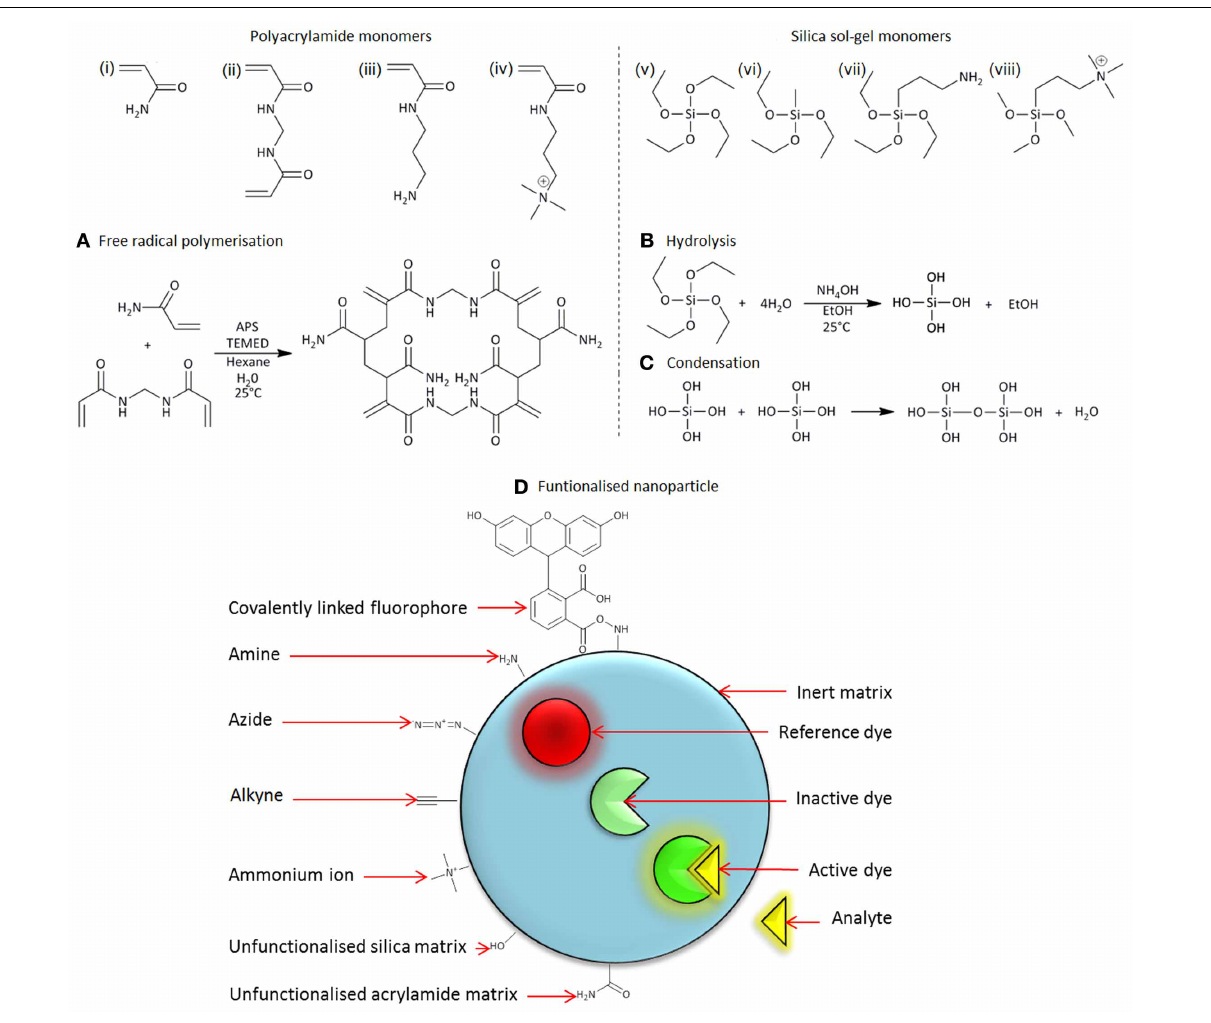
(MTEOS), (vii) (3-aminopropyl) triethoxysilane, and (viii)-trimethoxy silylpropyl-N,N,N- trimethyl-aminium (TMAC). (A) Free radical polymerization of polyacrylamide monomers. (B) Hydrolysis and (C) condensation of silica sol-gel monomers. (D) Diagrammatic representation of a functionalized